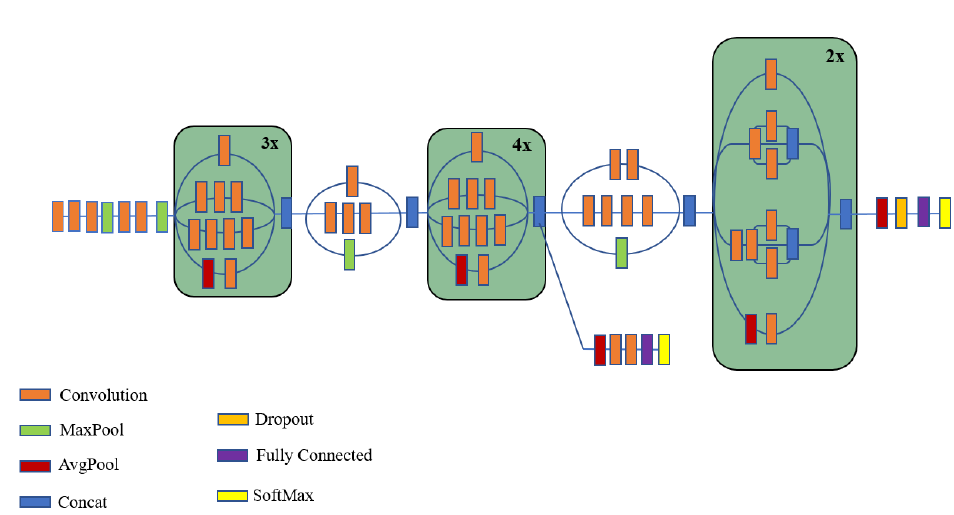
Figure 7. Architecture of Inception